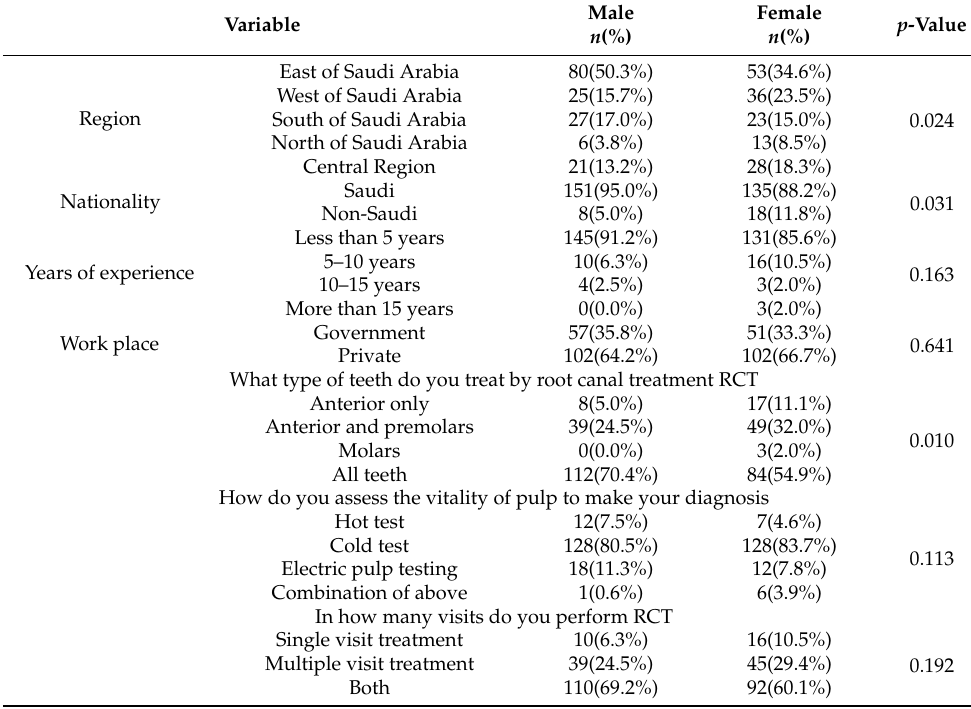
Table 3. Association of demographic profile and endodontic practices with respect to